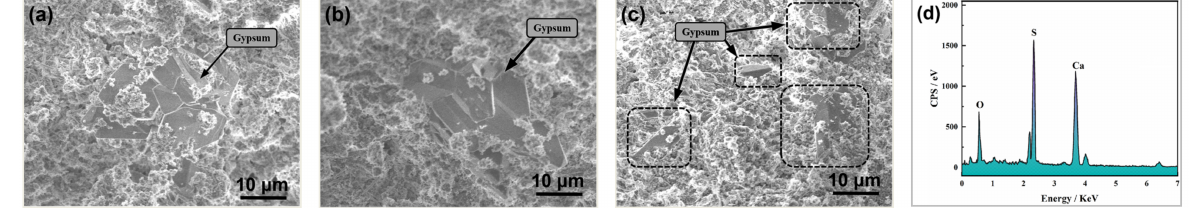
Figure 13. Different distribution patterns and EDS energy spectra of gypsum: ( a – c ) distribution patterns; ( d ) EDS energy spectrum of gypsum.